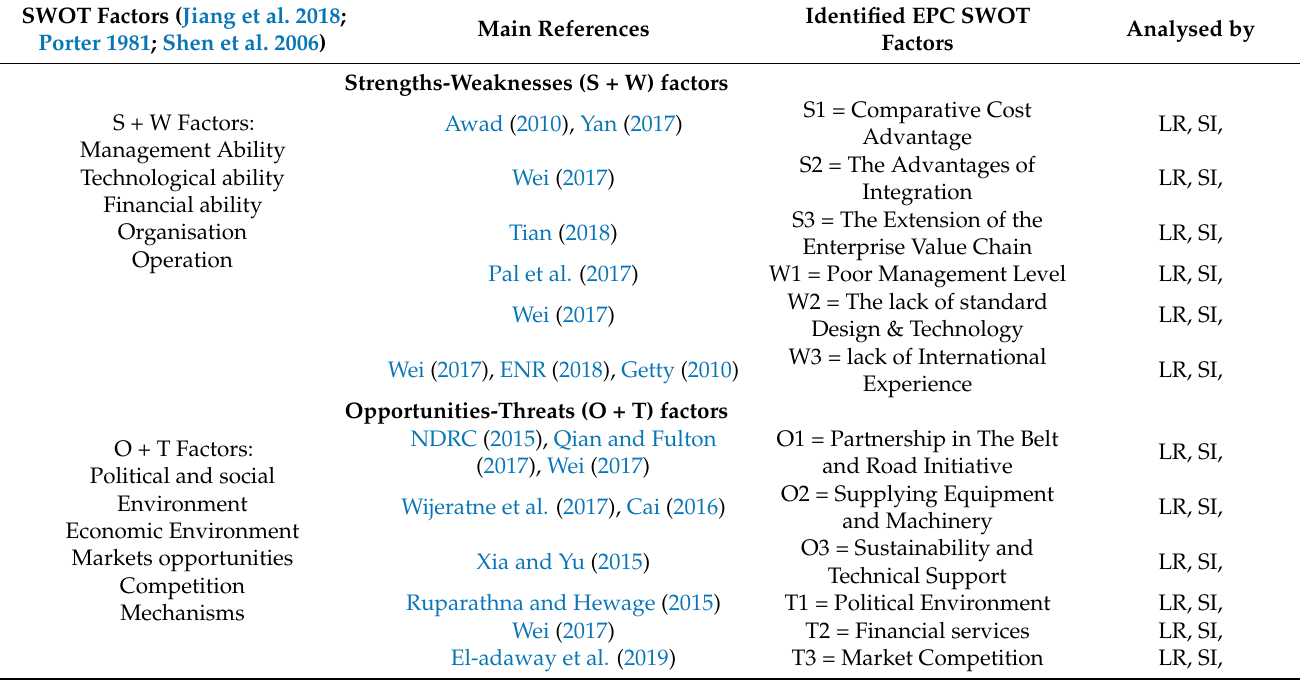
Table 2. Matrix of the SWOT analysis based on the interviews verified by the